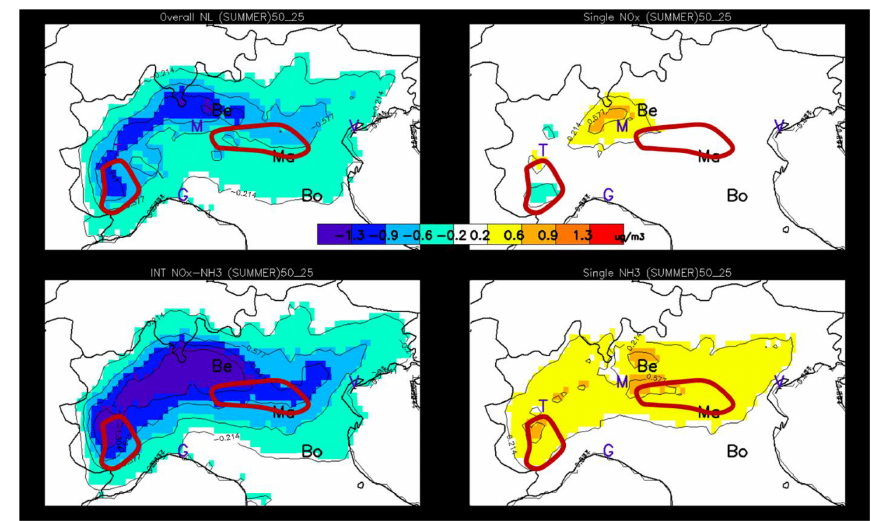
Figure 10. Same as Fig. 9 but for